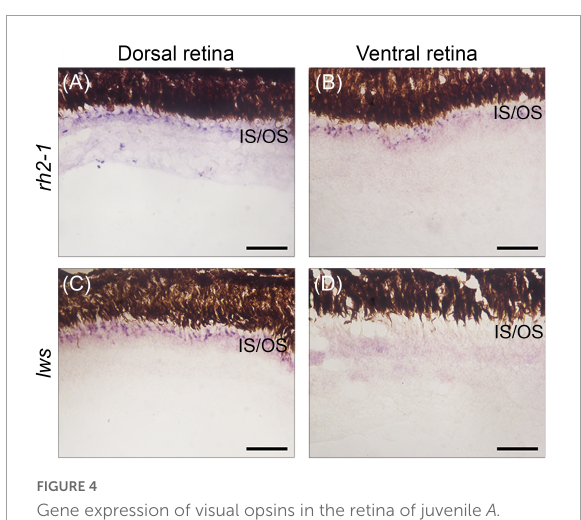
FIGURE4 Gene expression of visual opsins in the retina of juvenile A. anableps under light stimuli for 30 days. In situ hybridizations of rh2-1 (A,B) and lws (C,D) in dorsal and ventral retinas from juveniles of A. anableps . Scale bars: 0.05